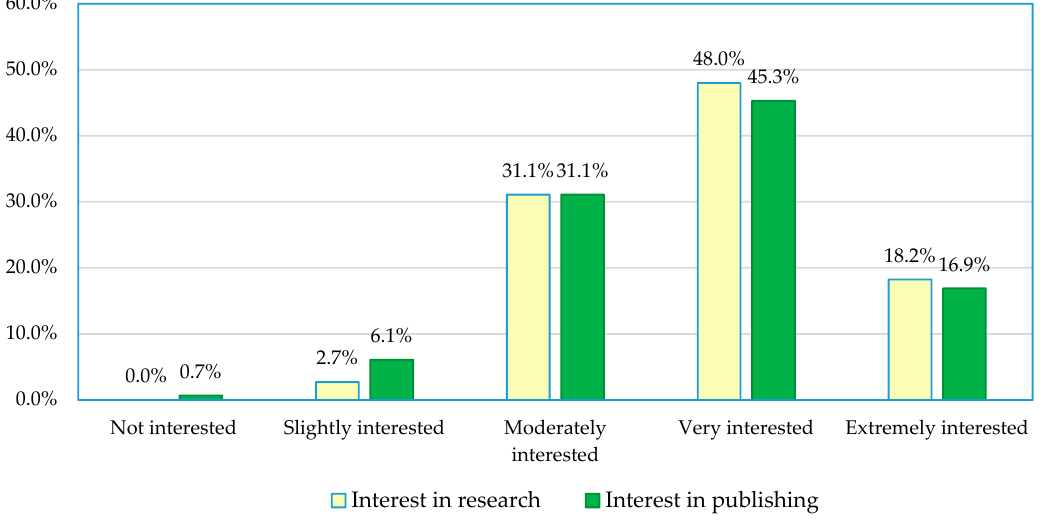
Figure 3. University lecturers’ interest in research and publishing.